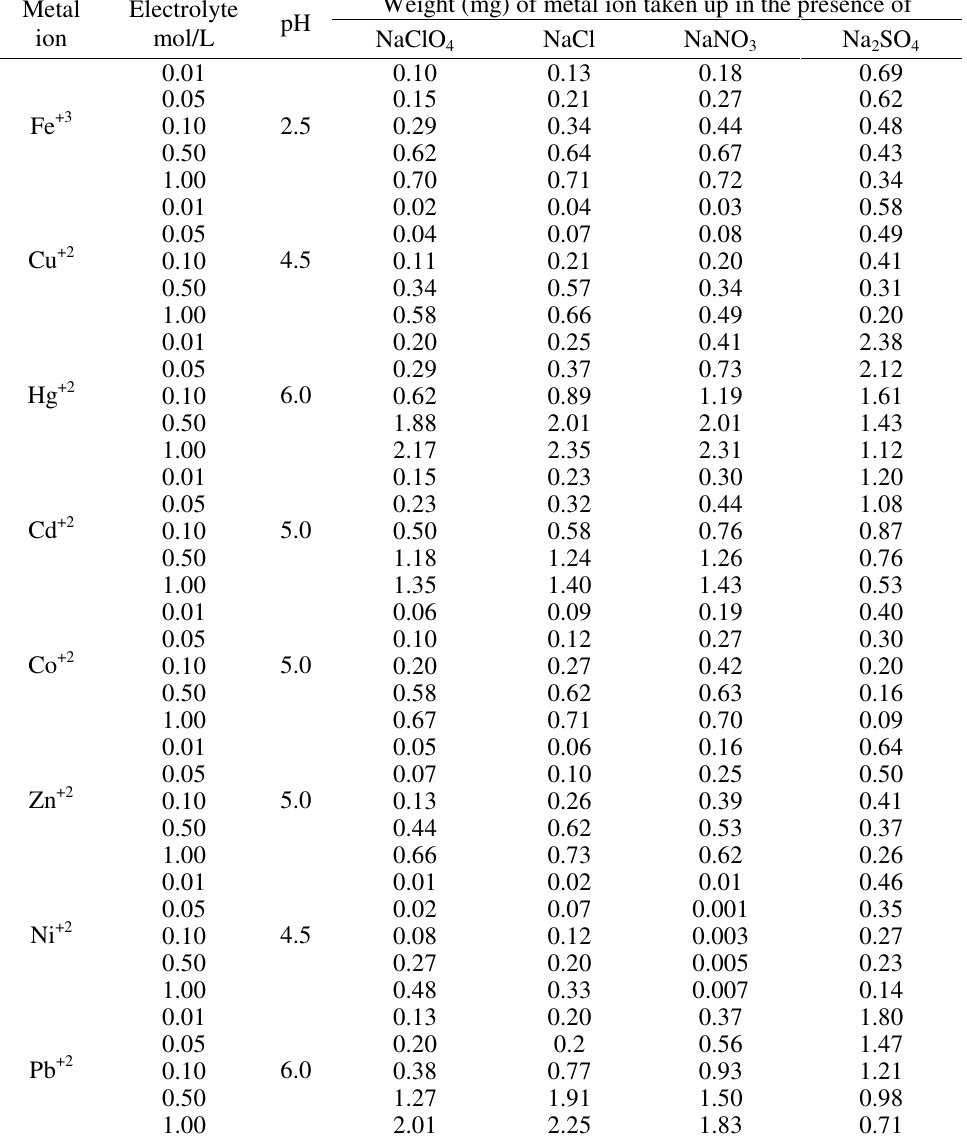
Table 5 . Evaluation of the effect of different electrolytes on the uptake of several metal ions a by 2,4-DHBOF-I terpolymers